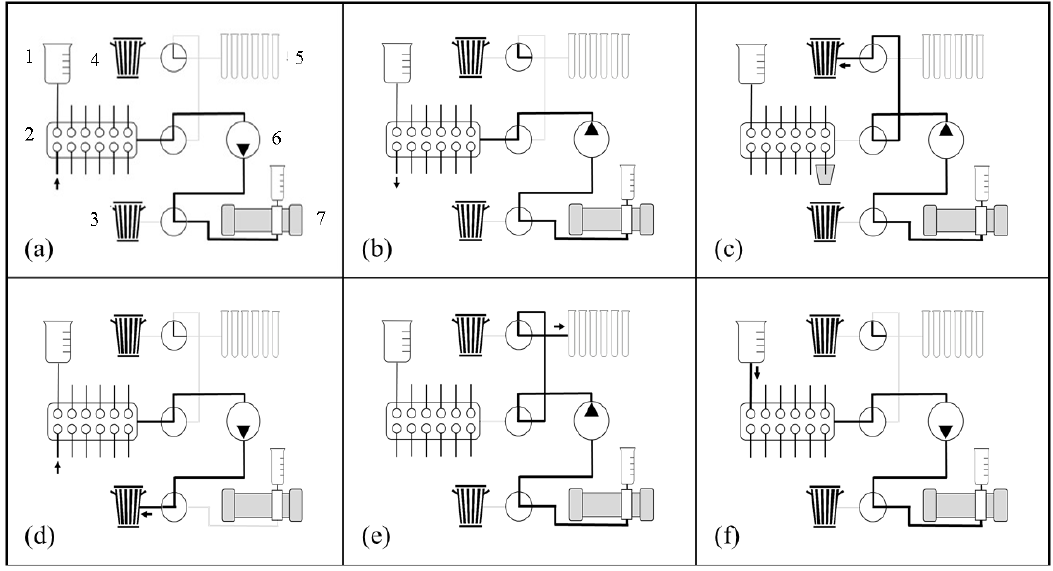
Figure 1. Graphical depiction of small-volume multiplexed pumping system (MPS) configurations which include (1) DI water source, (2) 12- port intake valve, (3, 4) waste or air purge, (5) fractional volume collector (FVC), (6) bidirectional peristaltic pump, and (7) spectrophotometer with cuvette housing. An Arduino microcontroller actuates a series of three-way valves to move between separate configurations (a–f) described in Sects.